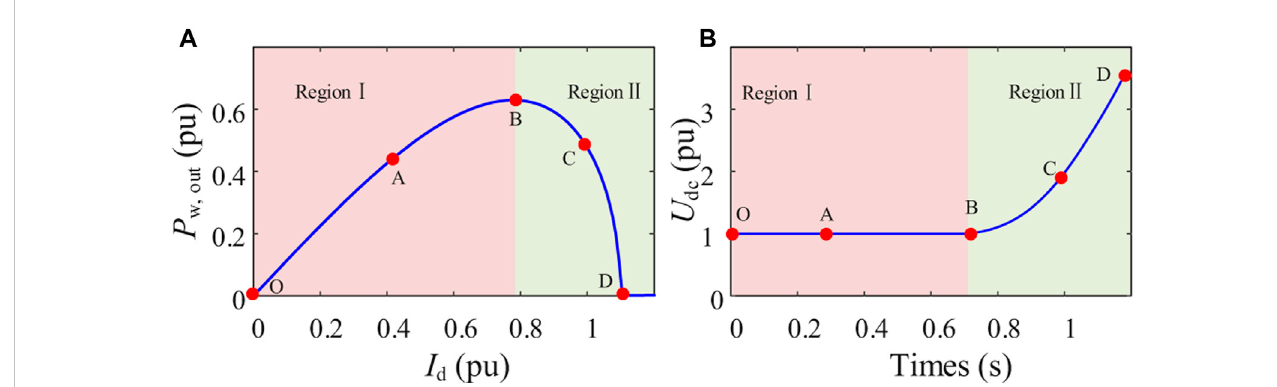
FIGURE 6 Power characteristic curve of OWF, (A) P w, out - I d characteristic curve, (B) U dc - t characteristic curve.